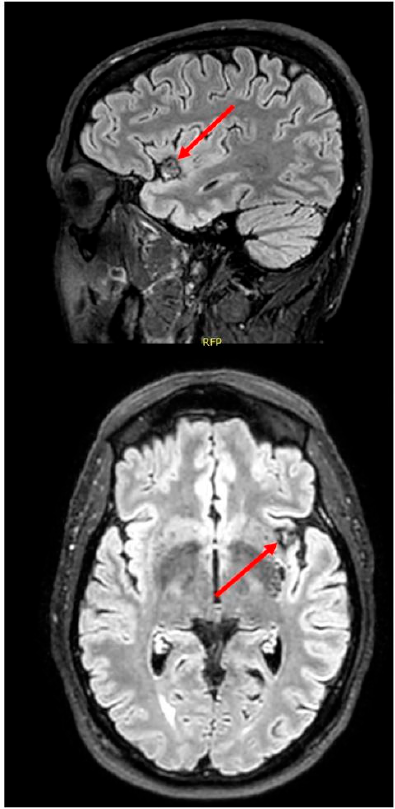
Figure 1. Brain magnetic resonance imaging (MRI) showing a left anterior insular cavernoma.